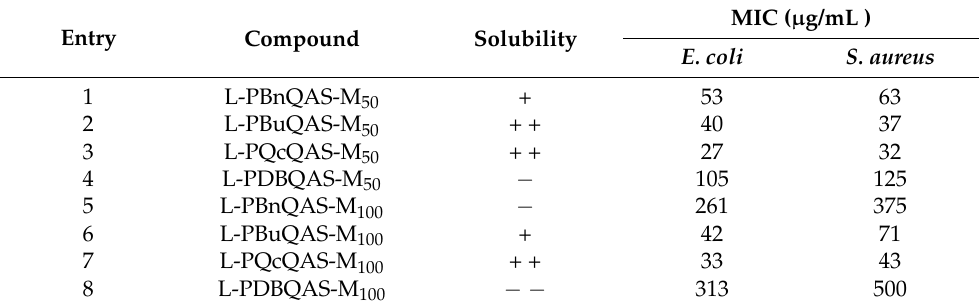
Table 2. Water solubility of the eight L-PQASs and its minimum inhibitory concentrations (MICs) against E. coli and S. aureus.